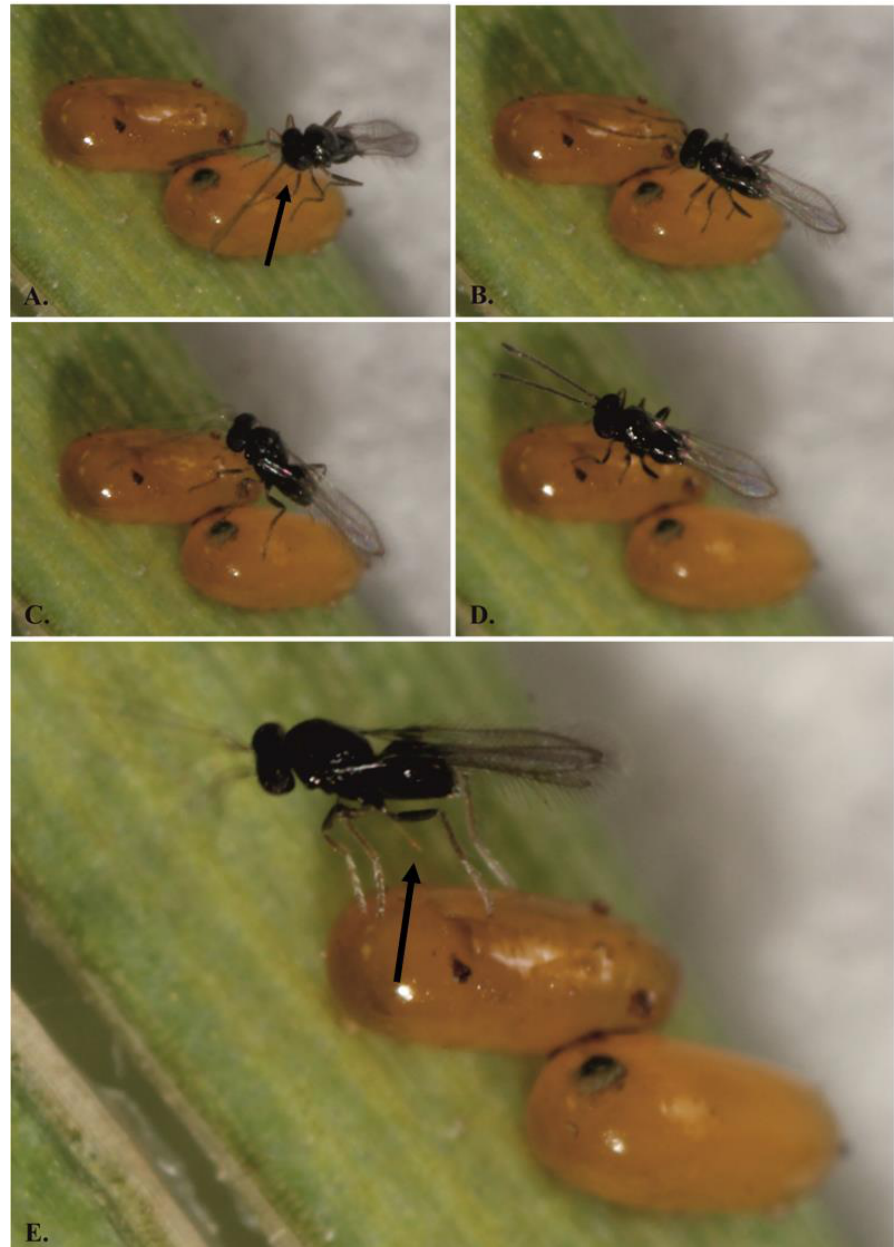
Figure 3. The parasitation on the non-sticky eggs by A. flavipes : ( A ) the female lays own eggs into the first egg of Oulema spp. (arrow indicates the ovipositor); ( B ) female ends the parasitization; ( C ) female examines the suitability of the second egg of Oulema spp. by its antennae; ( D ) the female lays own eggs; ( E ) female ends the parasitization (arrow indicates the ovipositor).